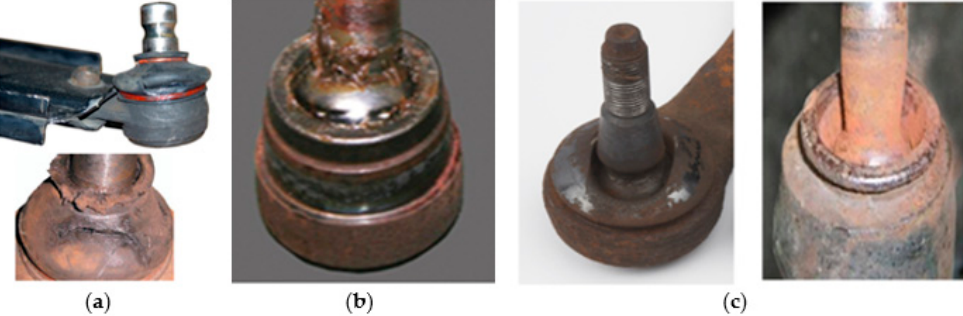
Figure 2. The most often defects of the ball joints: ( a ) Ripped rubber cover; ( b ) Frozen ball joint; ( c ) Corrosion of a